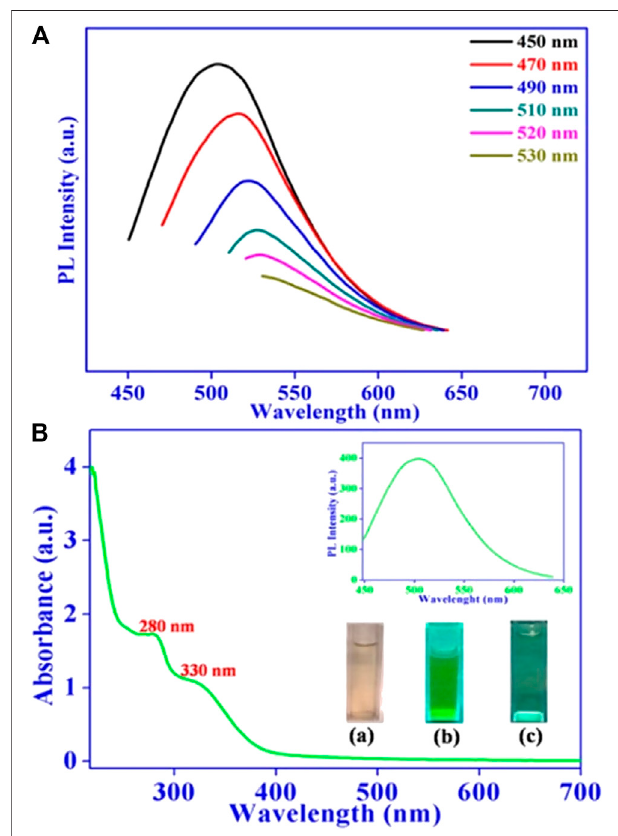
FIGURE 3 | (A) Fluorescence emission spectrum of C-Dots gained at different excitation wavelengths. (B) UV-vis absorption spectrum C-Dots synthesized from Ocimum sanctum leaves (Kumar et al.,